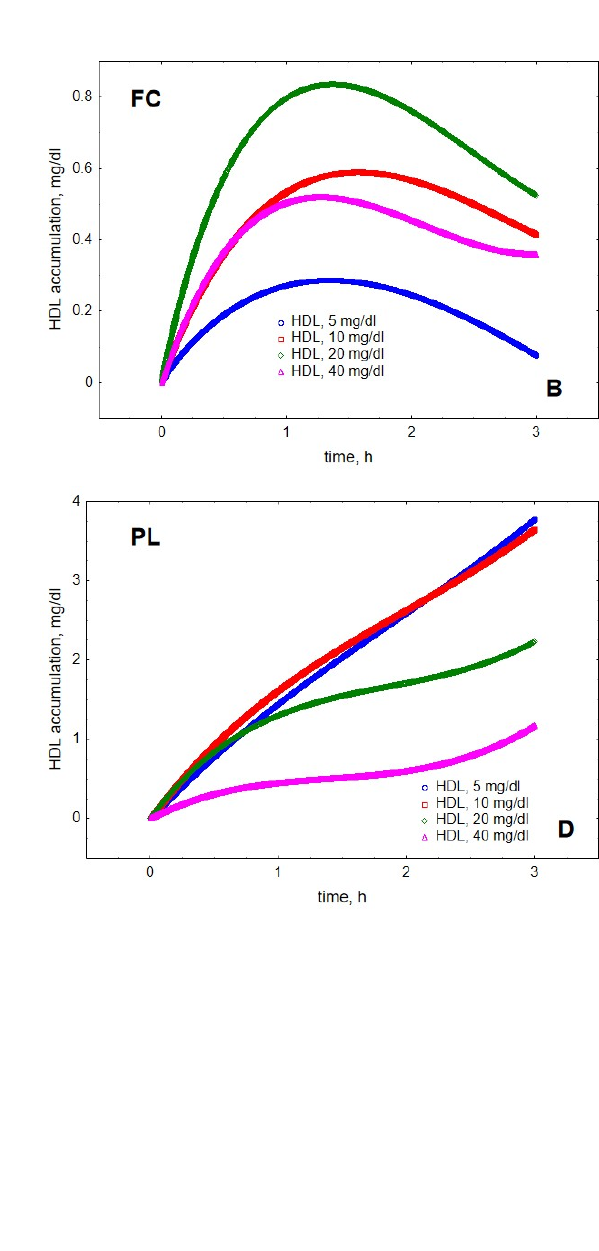
(red squares), 20 (green diamonds) and 40 (purple triangles) mg total mass/dl; VLDL-TG, 30 mg/dl; LPL, 190 U/mL.